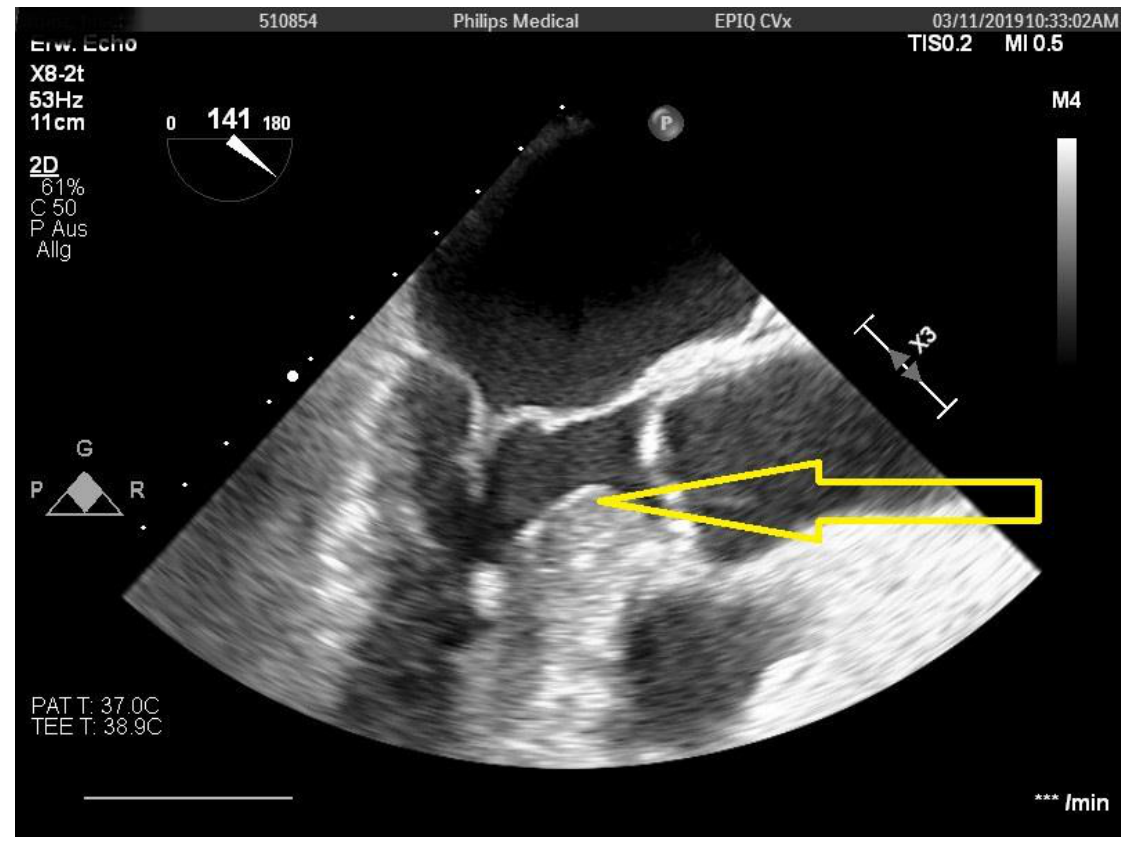
Figure 1. Thickened septum in left ventricular outflow tract (indicated by yellow arrow).